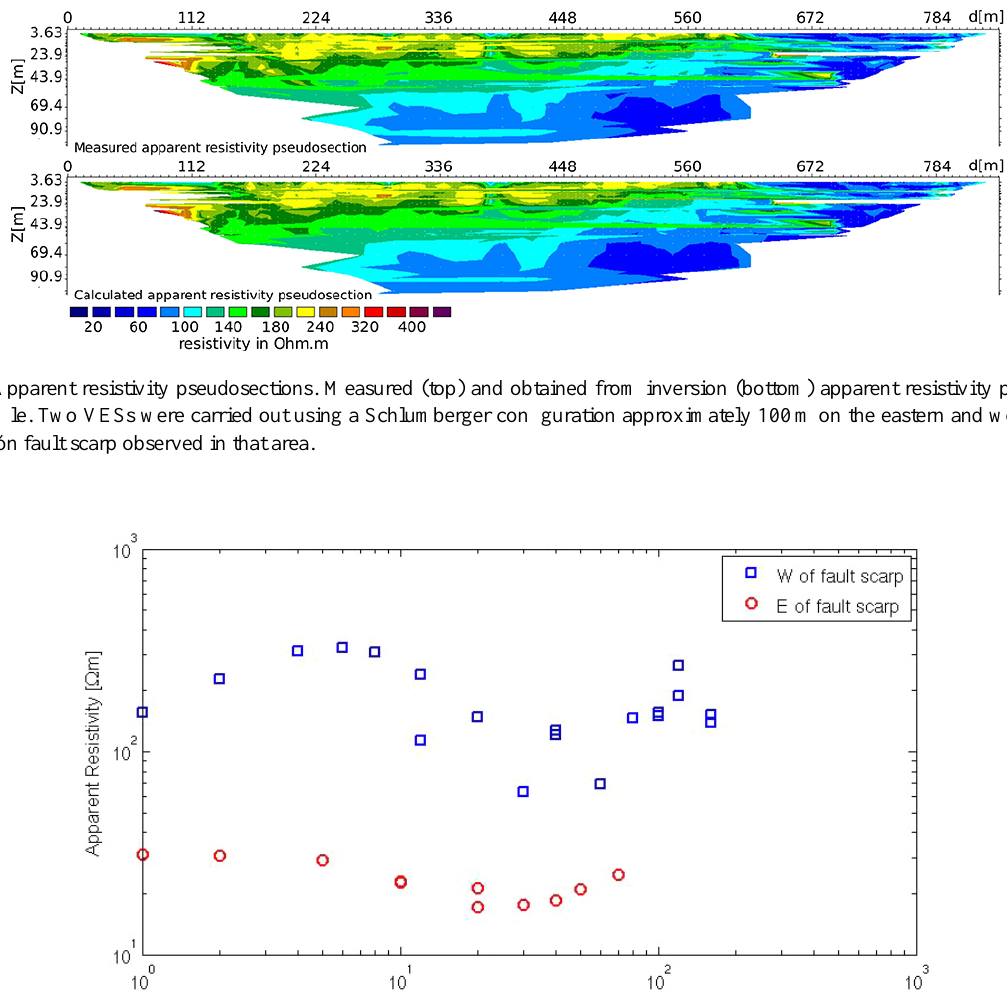
Solid Earth, 5, 837–849, 2014